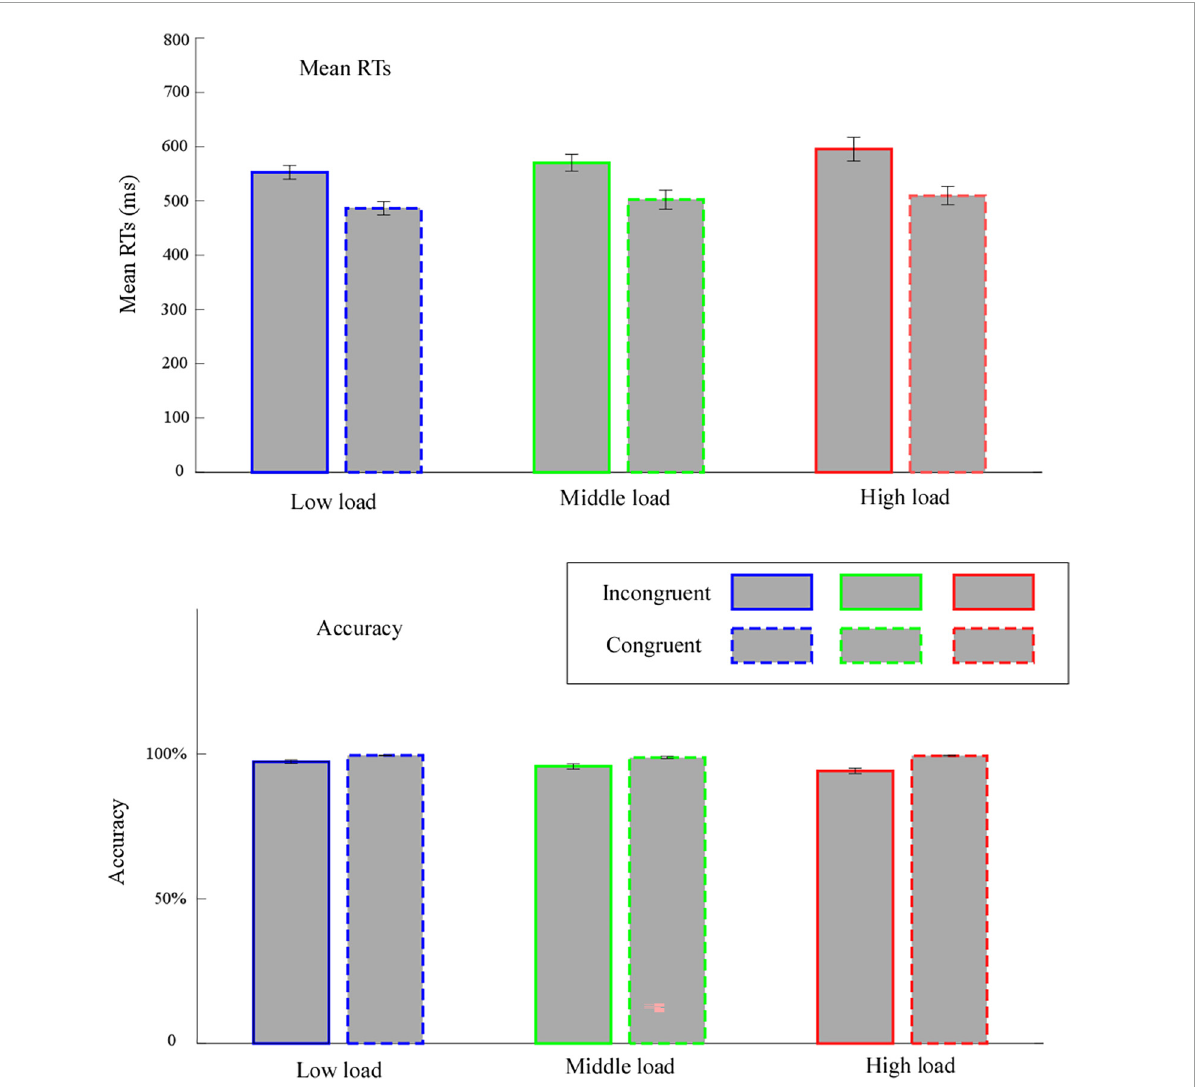
FIGURE2 Mean values for reaction times (RTs) and accuracy. Error bars represent within-subject standard error of the means. Low load, low WM load; middle load, middle WM load; high load, high WM